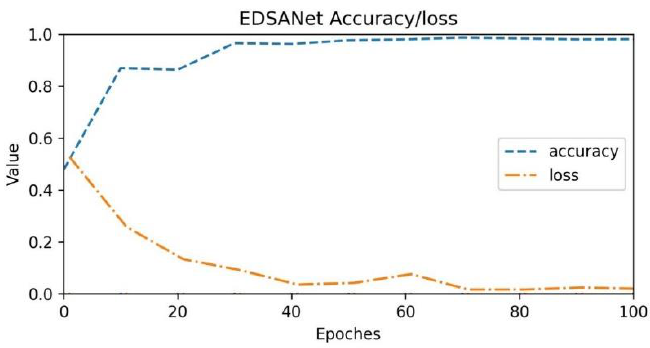
Flip vertically Figure 6. An example of data augmentation by rotating and flipping the rural Weinan building da- taset. 3.3. Experimental Setting The experiments were conducted using the PyTorch deep learning framework. All